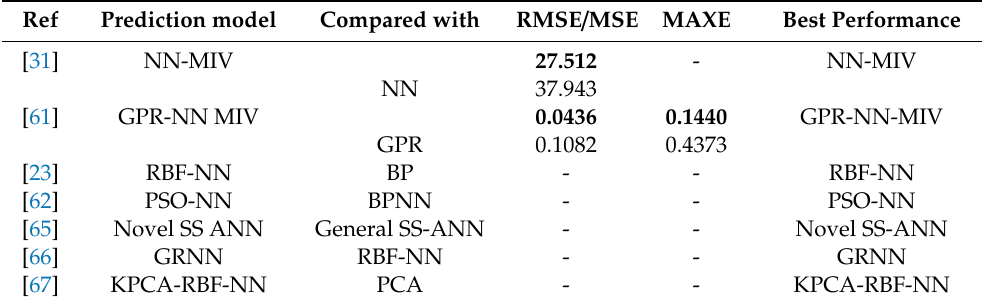
Table 3. Comprehensive analysis of soft sensor models based on NN / ANN (for the list of abbreviations see Table